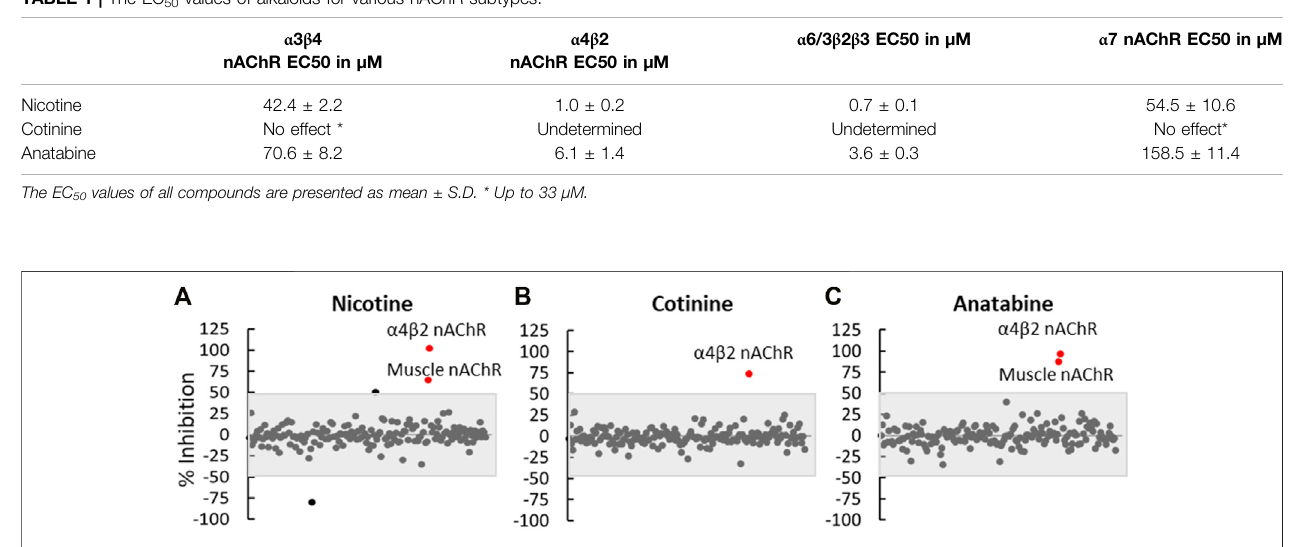
FIGURE 7 | Off-target effect assessment. (A) Nicotine, (B) cotinine, and (C) anatabine were tested in 175 in vitro binding or functional assays as summarized in Supplementary Material S2 . Each dot represents the outcome of one assay. The grey shaded area covers any assay that showed an effect smaller than 50%. Red dots represent assays that showed greater than 50% change by the respective compounds compared to the vehicle control. N = three